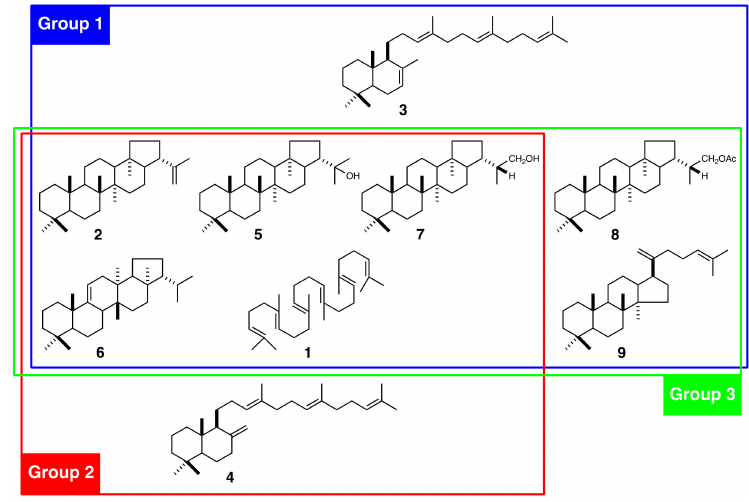
Figure 1. Triterpenoids isolated from Polystichum ferns and chemotaxonomic classification based on the triterpenoid profile. Group 1 includes P. polyblepharum , P. fibrilloso-paleaceum , and P. pseudo-makinoi ; Group 2 includes P. rigens ; and Group 3 includes P. longifrons , P. makinoi , and P. lepidocaulon . 1 , squalene; 2 , hop-22(29)-ene; 3 , γ -polypodatetraene; 4 , α -polypodatetraene; 5 , 22-hydroxyhopane; 6 , fern-9(11)-ene; 7 , dryocrassol; 8 , dryocrassyl acetate; and 9 ,